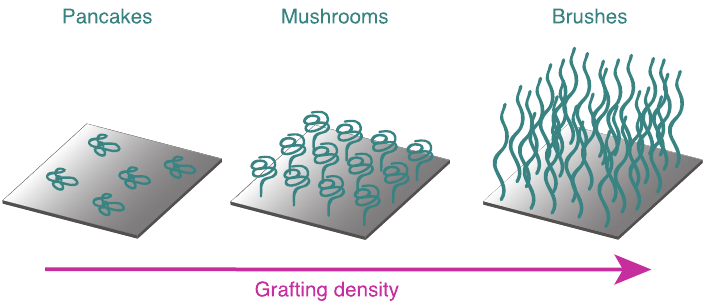
Figure 3. Schematic illustration of the structure of grafted polymer chains with increasing grafting density, from ’pancakes’ via ’mushrooms’ to